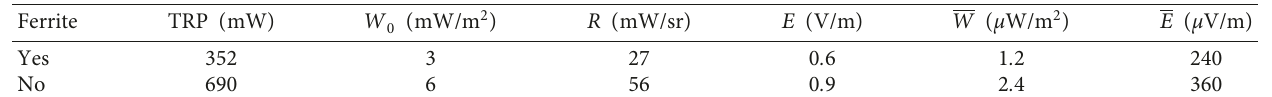
Figure 17: Emission diagram in vertical polarization in the 3 rd plane (dbm). Table 3: Measurement